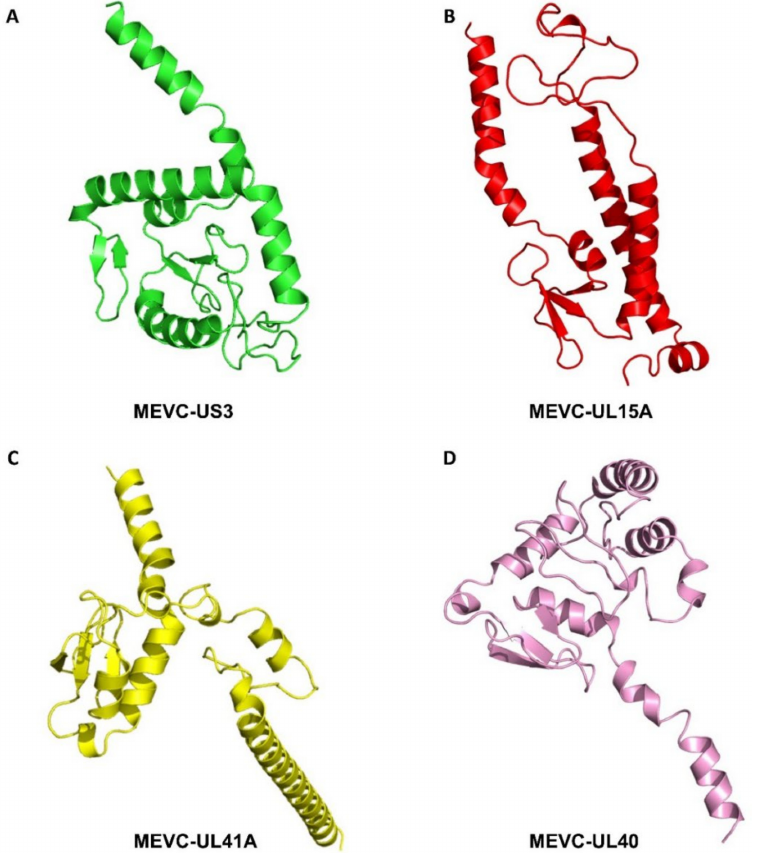
Figure 3. ( A – D ) Represents the predicted 3D structures of final multi-epitope-based vaccine designs for HCMV